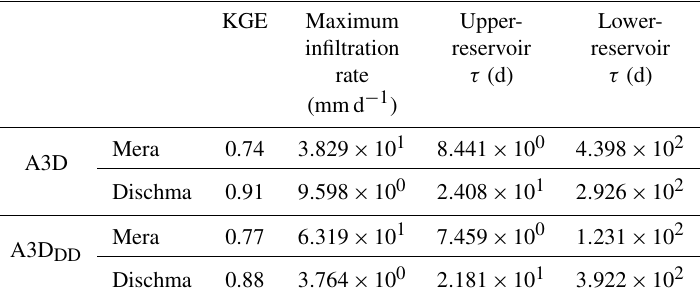
Table 6. StreamFlow calibration